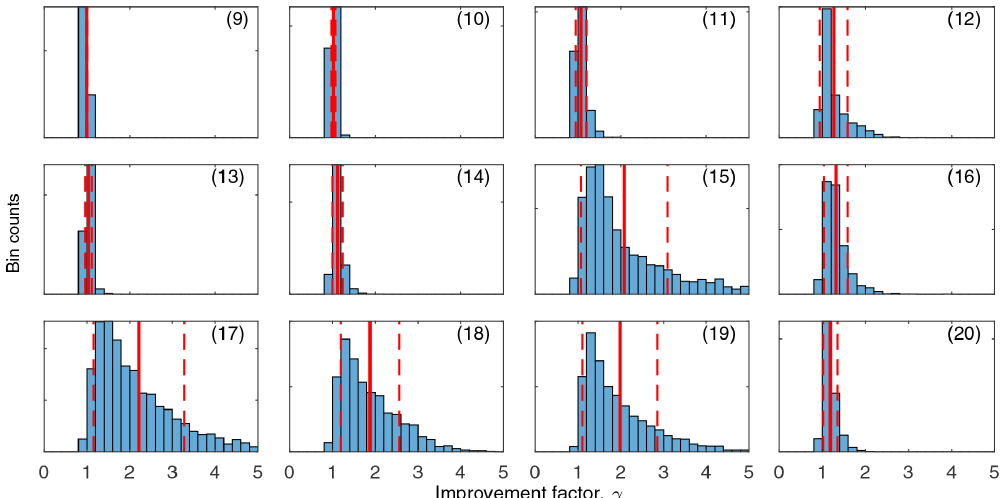
Figure 6. Histogram of improvement factors for gates 9–20 presented as bin counts. The bin count axis is individually scaled for each histogram to make the distribution visible. The full red line shows the mean value of improvement factor; the dashed red lines show the standard deviation.